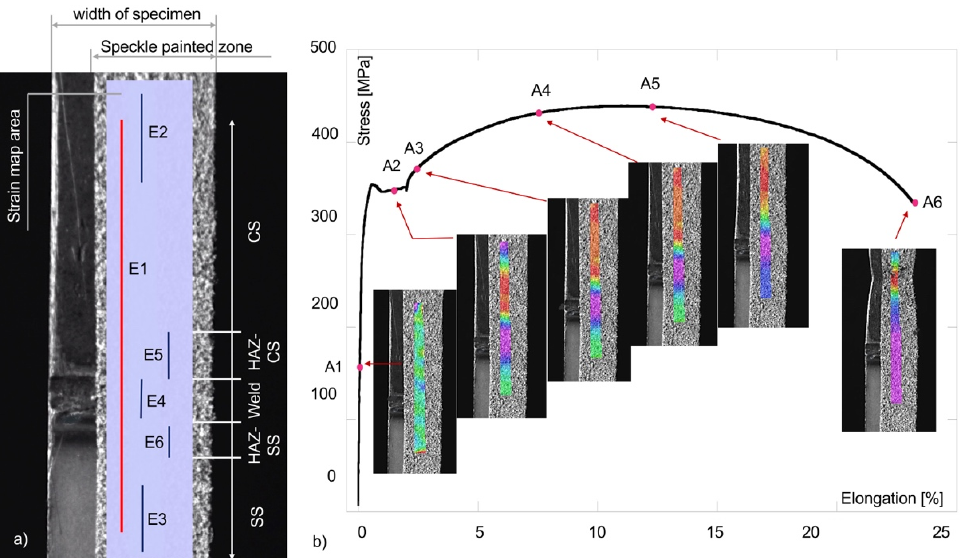
Figure 7. Overall stress–percentage elongation curve of the LW joint. ( a ) Flat specimen detail on which are indicated the speckle-painted zone and the generic positions of the six virtual extensometers (E1–E6) with respect to the LW-joint zones, and the strain field analysis area; ( b ) overall stress vs. percentage elongation of the LW joint; the images are the strain maps corresponding to the points A1–A6.